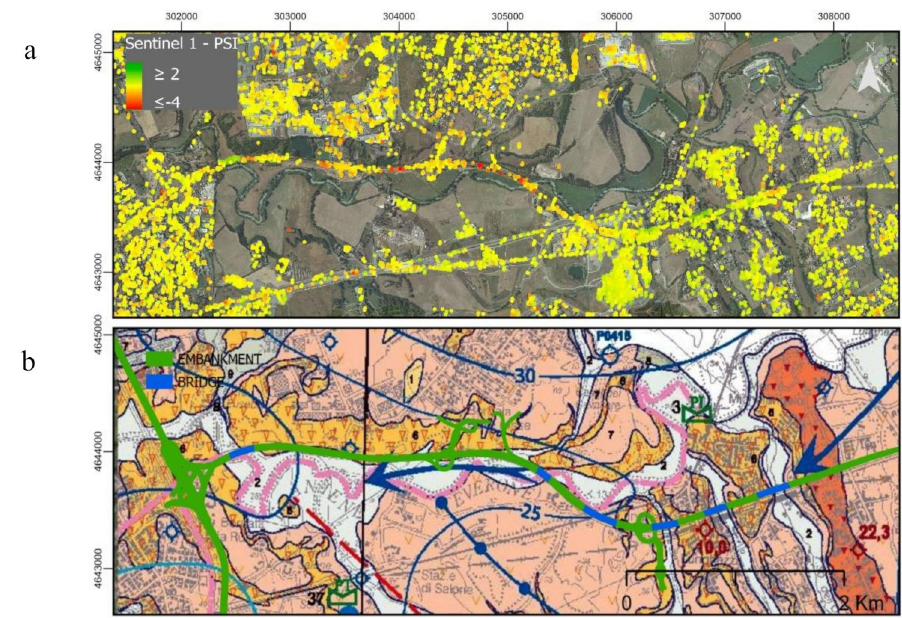
Figure 9. ( a ) Displacement map PSI Sentinel-1 for A24 Highway (Rome-Aquila), as background orthophoto Rome 2011. ( b ) The detail of the position of the A24 highway on the hydrogeological map of Rome (Vigna et al., 2015) shows the morphology, the position of the anthropogenic, and the volcanic deposit indicates that the flow of groundwater (blue arrow), indicates the current course of the Aniene (pink line).